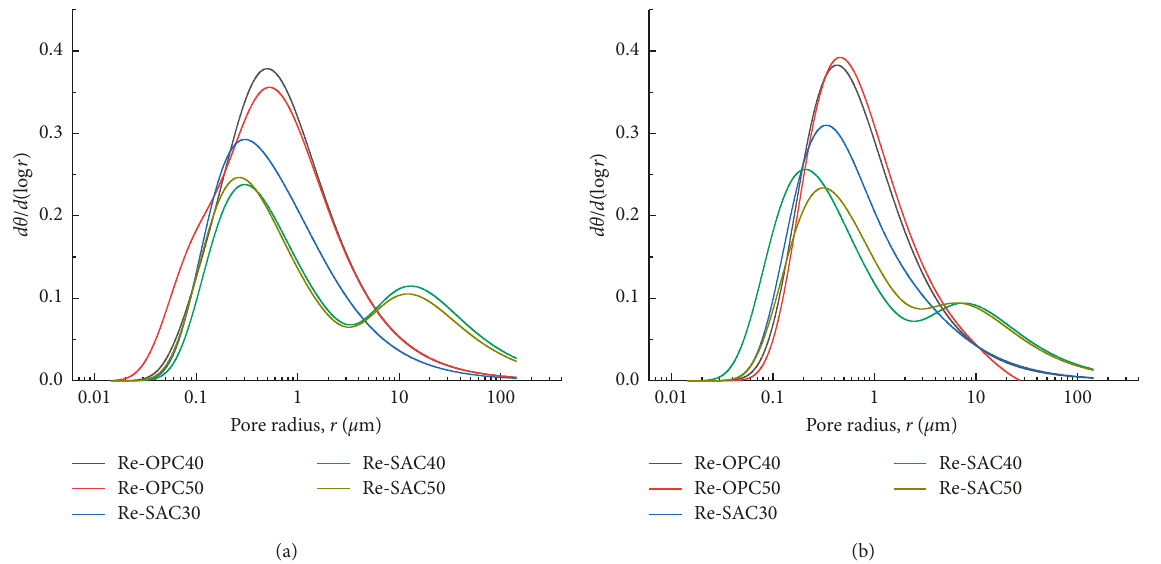
Figure 7: Effective pore-size distribution of remolded solidified sludge. (a) Time � 7/0 days. (b) Time � 7/21days.